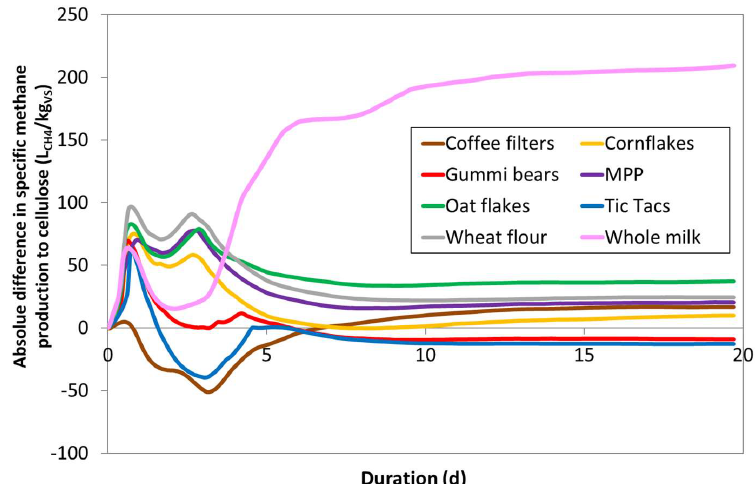
Figure 3. Absolute difference in the specific methane production relative to microcrystalline cellulose of the eight alternative positive control substrates tested.